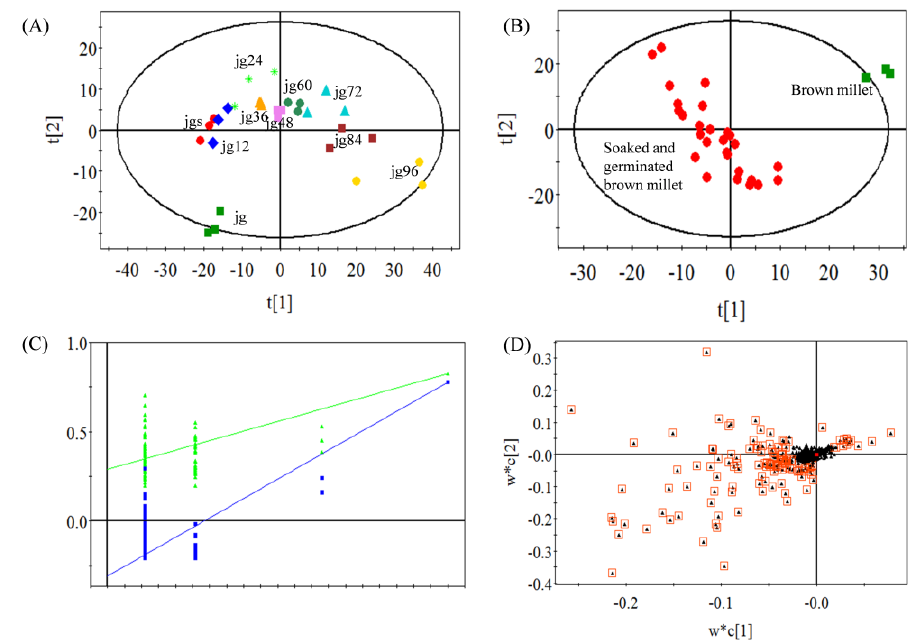
Figure 1. Multivariate statistical analysis of the volatiles during foxtail millet germination: ( A ) principal component analysis (PCA) score plot; ( B ) Partial least squares-discriminate analysis (PLS-DA) score plot, R 2 X = 0.523, R 2 Y = 0.827, Q 2 = 0.778; ( C ) Cross-validation plot of the PLS-DA model with 100 permutation tests (intercepts of R 2 and Q 2 are 0.306 and − 0.268, respectively); ( D ) PLS-DA loading plot (black triangles with boxes represented most di ff erential metabolites). jg, jgs, and jg12–96 represented the raw brown millet, soaked brown millet, and germinated millet, respectively.